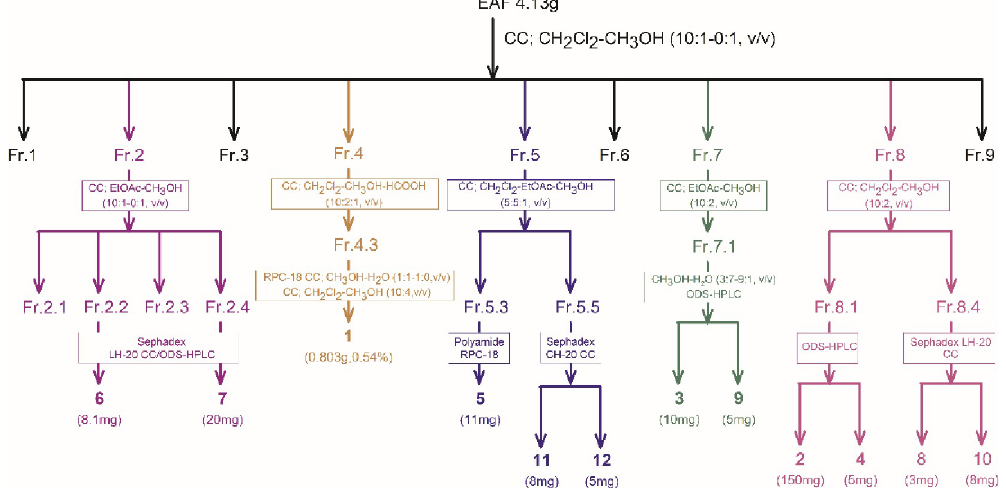
Fig 1. The fractionation of the ethyl acetate fraction (EAF) by sequential separation with solvents and column chromatography.